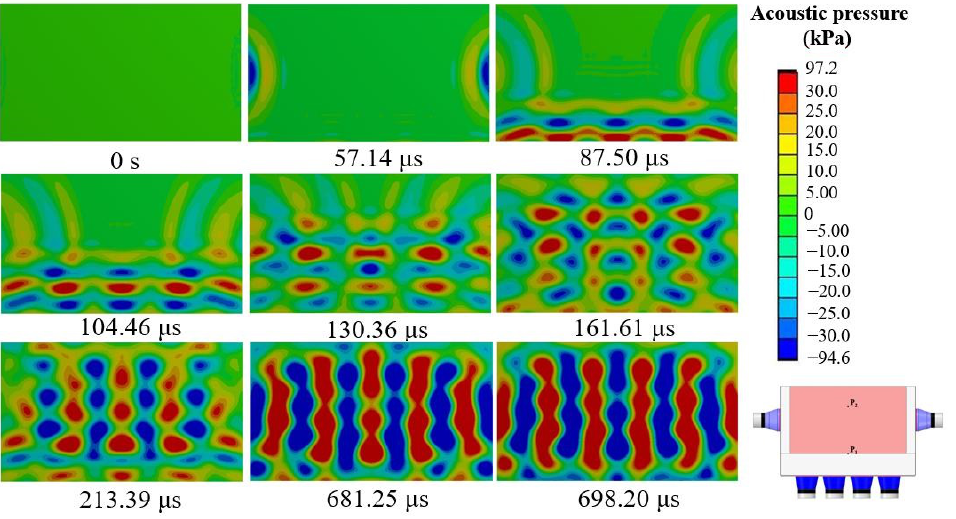
Figure 12. Acoustic pressure distribution in terms of time at S 1 for model A.